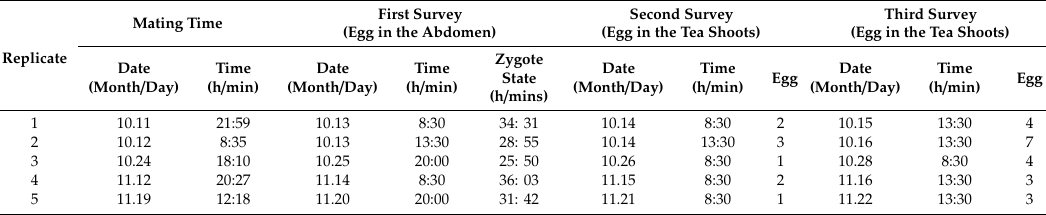
Table 4. Fertilized ovum state and the initial egg laying of E. onukii